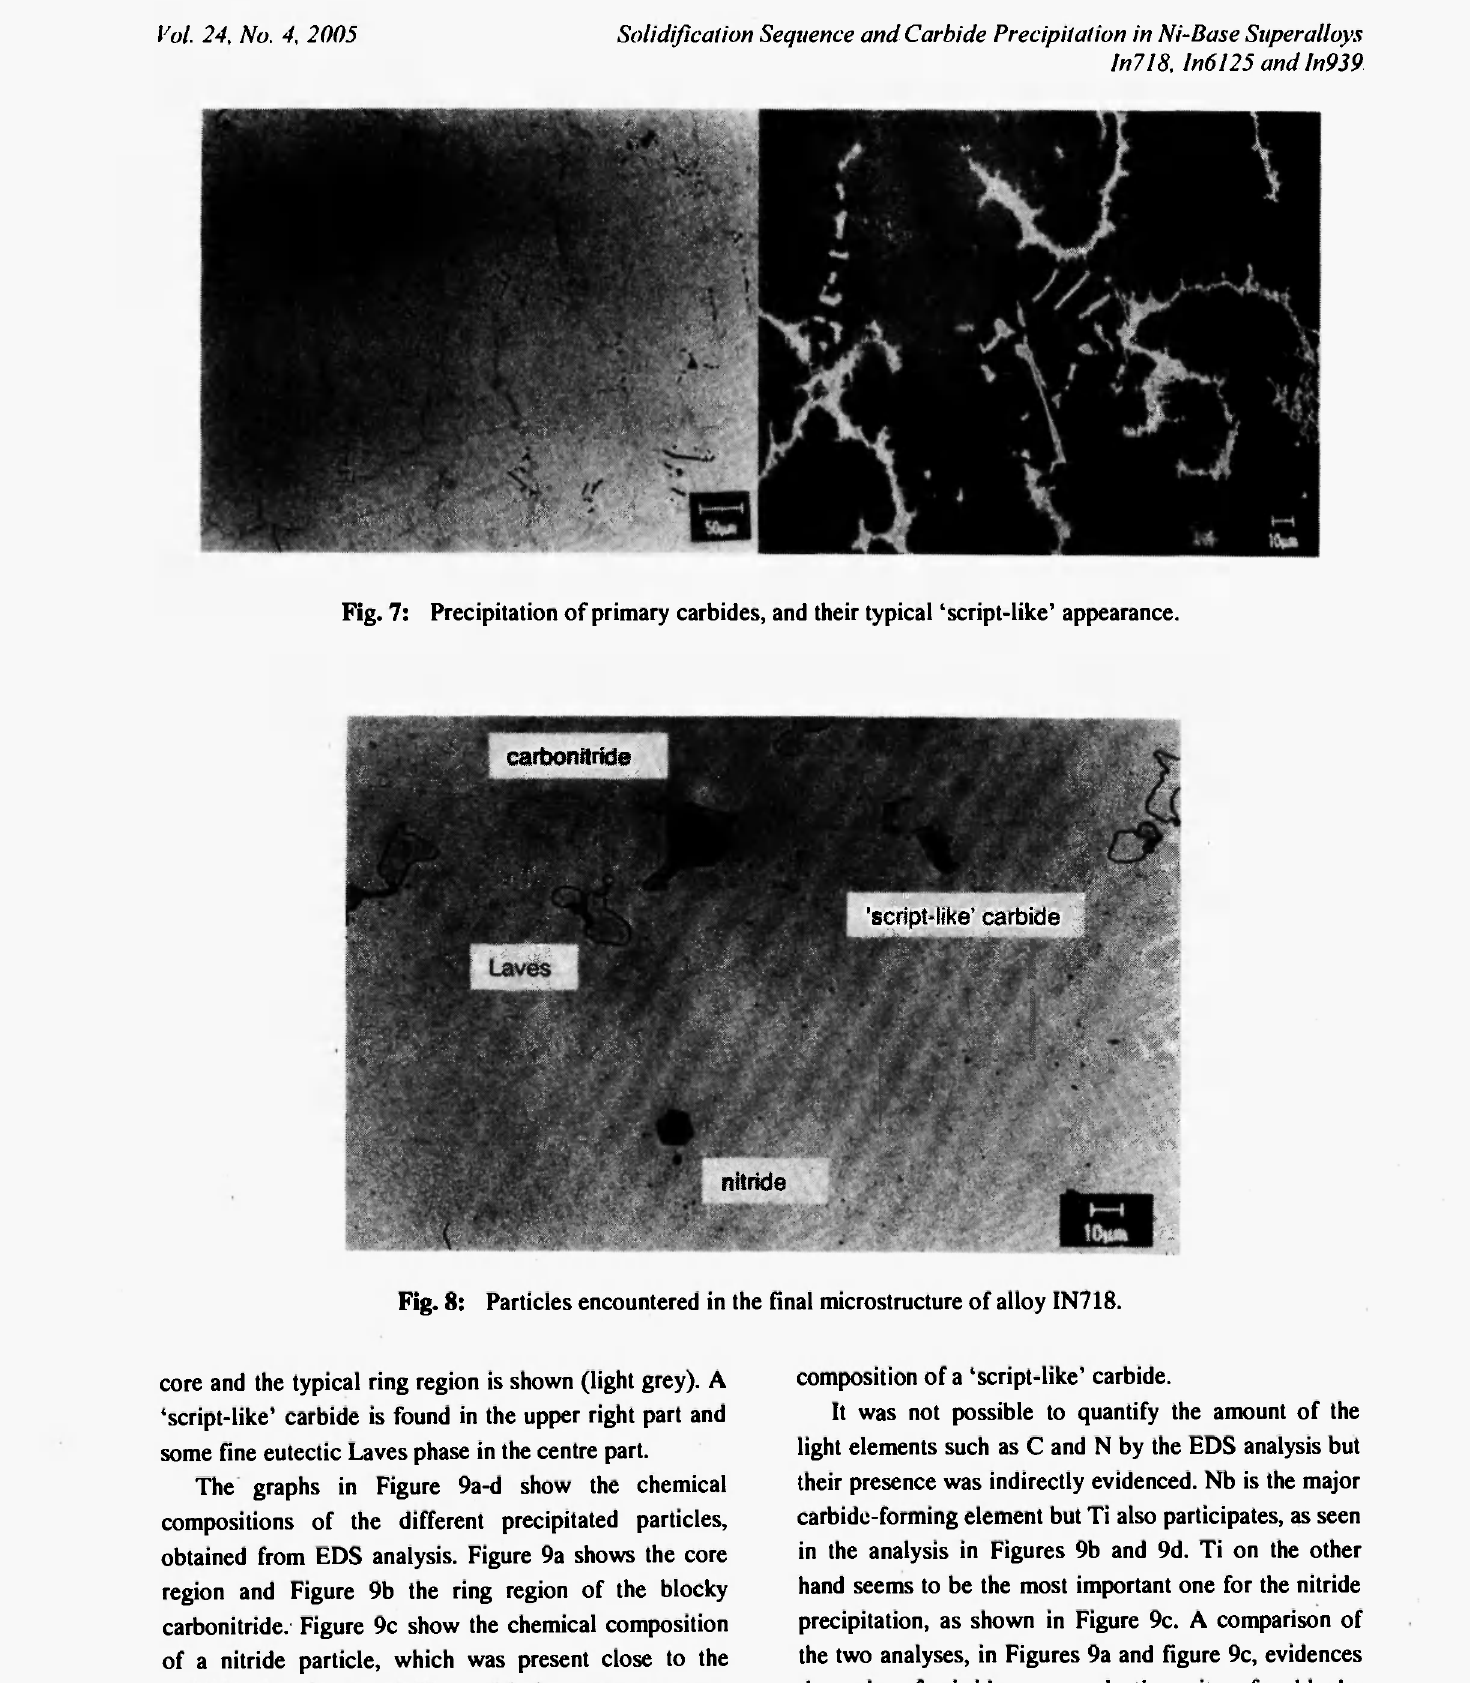
Fig. 8: Particles encountered in the final microstructure of alloy